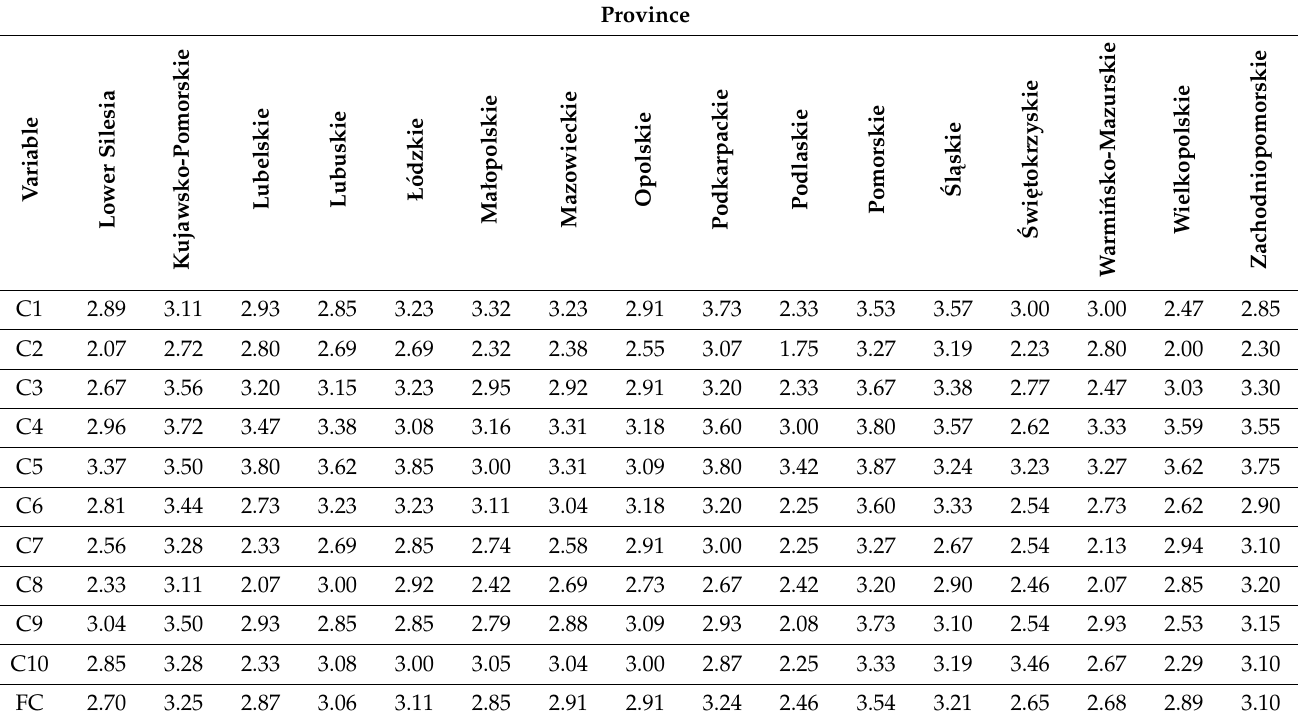
Table 3. Assessment of variables in the functioning of the creative sector in Polish cities by province.